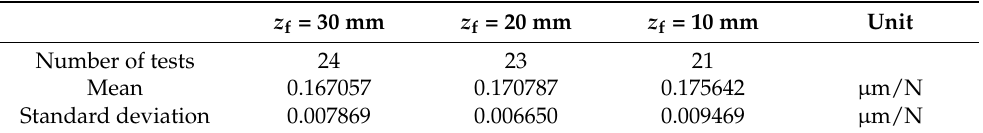
Table 2. Compliance test results for different relative tool positions z f .